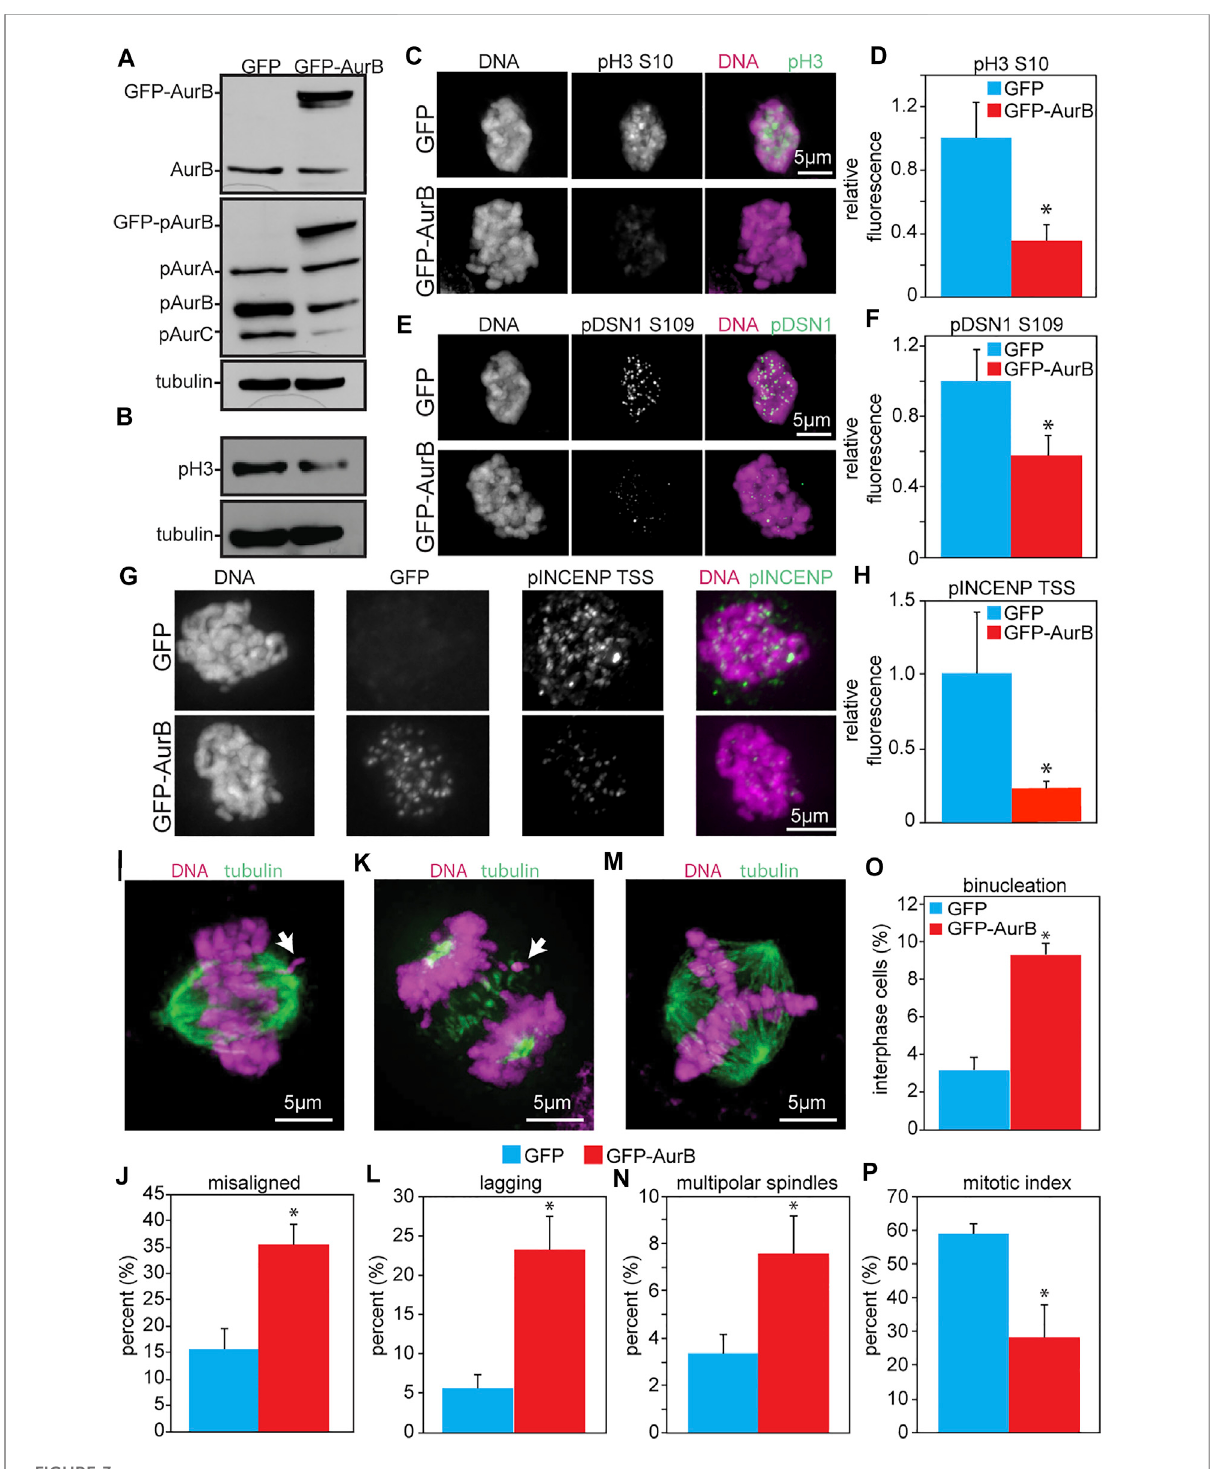
Expression of GFP-Aurora B in HeLa cells causes a reduction in Aurora B kinase activity and an increase in mitotic defects. Cells were analyzed 48 h after infection with retroviruses expressing GFP-Aurora B or GFP alone. (A) Immunoblot showing endogenous pT232 (active) Aurora B is reducedinHeLacellsoverexpressingAuroraB.Tubulinisshownasaloadingcontrol. (B) Immunoblotshowingreducedphosphorylationofthebona fi de Aurora B substrate histone H3 Serine 10 in HeLa cells infected with retroviruses expressing GFP-Aurora. Tubulin is shown as a loading control. (C – H) Quantitative immuno fl uorescence demonstrating that expression of GFP-Aurora B decreases phosphorylation of histone H3 (pH3), the kinetochore component DSN1, and INCENP in HeLa cells. (C,E,G) Representative images of pH3, pDSN1, and pINCENP, respectively, in